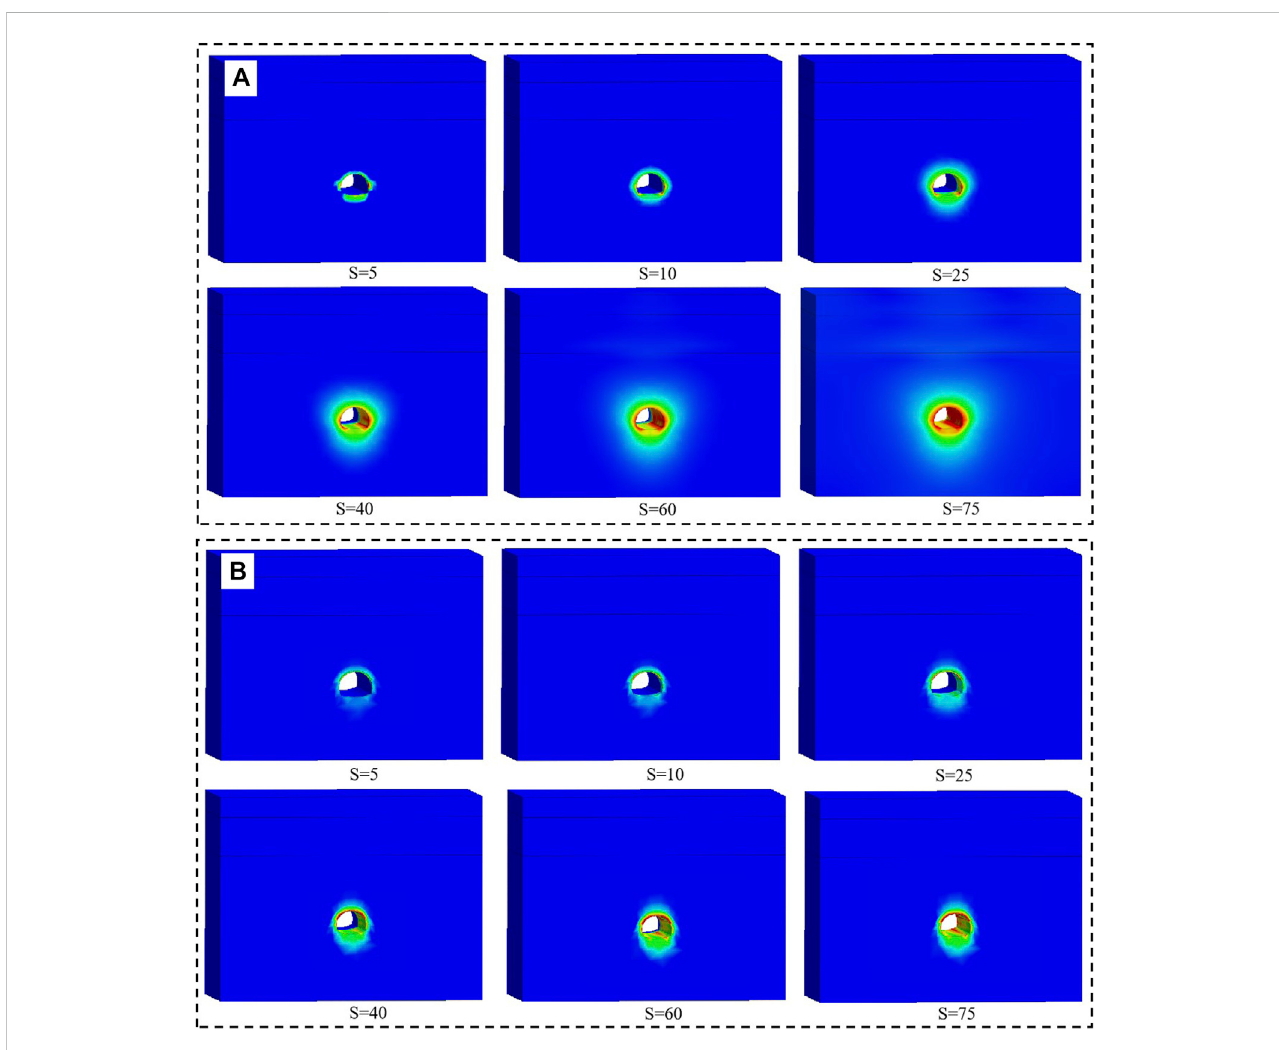
FIGURE 9 Development process of plastic zones under two construction schemes: (A) original construction scheme and (B) improved construction